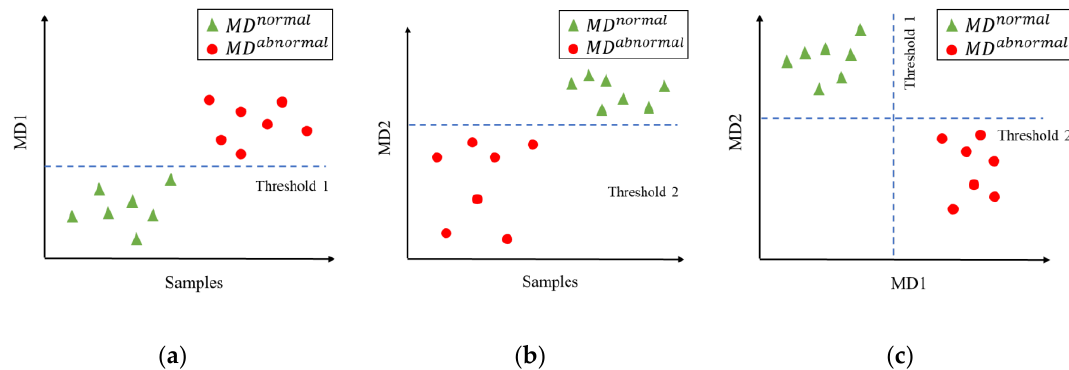
Figure 2. Three di ff erent classification scenarios, listed as ( a ) reference MD space based on MD normal ; Figure 2. Three different classification scenarios, listed as ( a ) reference MD space based on 𝑴𝑫 𝒏𝒐𝒓𝒎𝒂𝒍 ; ( b ) reference MD space based on MD abnormal ; ( c ) reference MD space based on both MD normal ( b ) reference MD space based on 𝑴𝑫 𝒂𝒃𝒏𝒐𝒓𝒎𝒂𝒍 ; ( c ) reference MD space based on both 𝑴𝑫 𝒏𝒐𝒓𝒎𝒂𝒍 and and MD abnormal 𝑴𝑫 𝒂𝒃𝒏𝒐𝒓𝒎𝒂𝒍 .